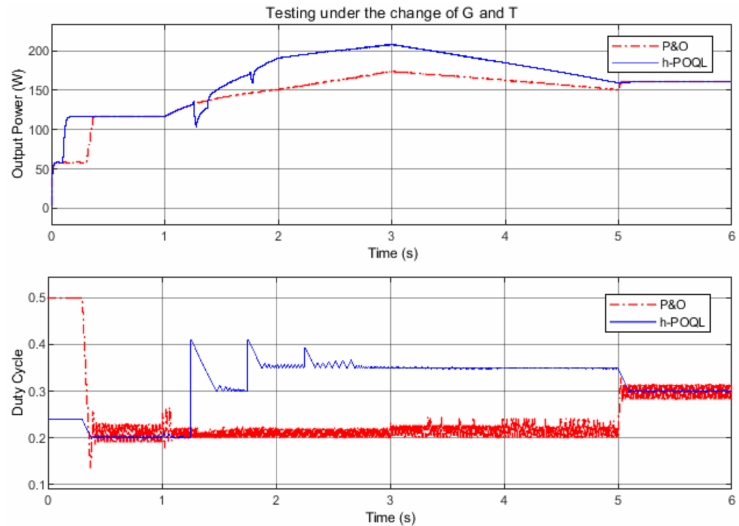
Figure 22. Comparison between the h-POQL and the P&O